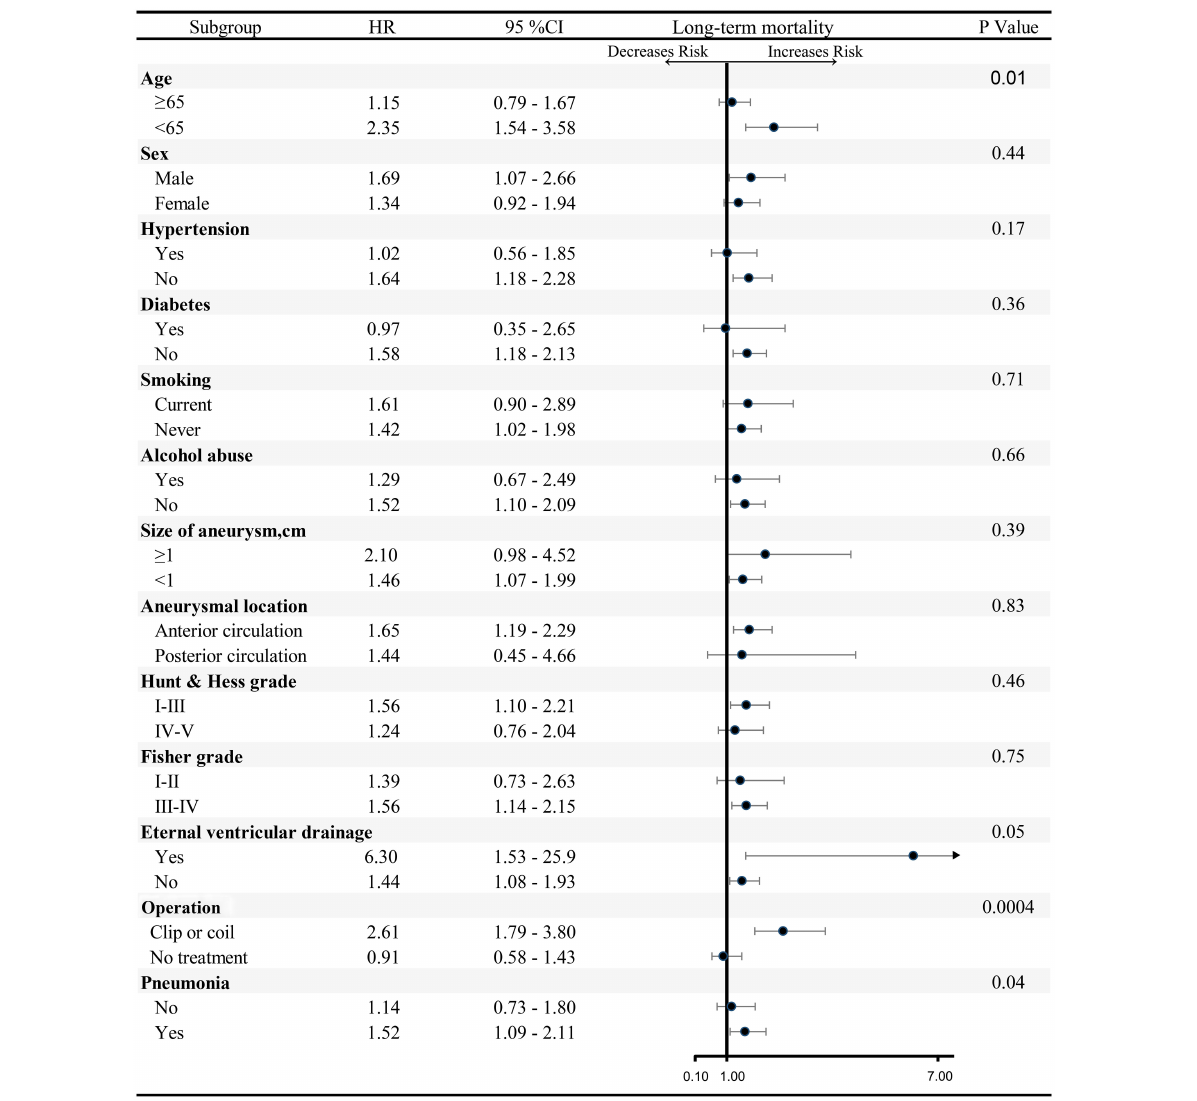
FIGURE 3 | Subgroup analysis of association between COPD and long-term mortality. EVD, External ventricular drain; COPD, chronic obstructive pulmonary disease; HR, hazard